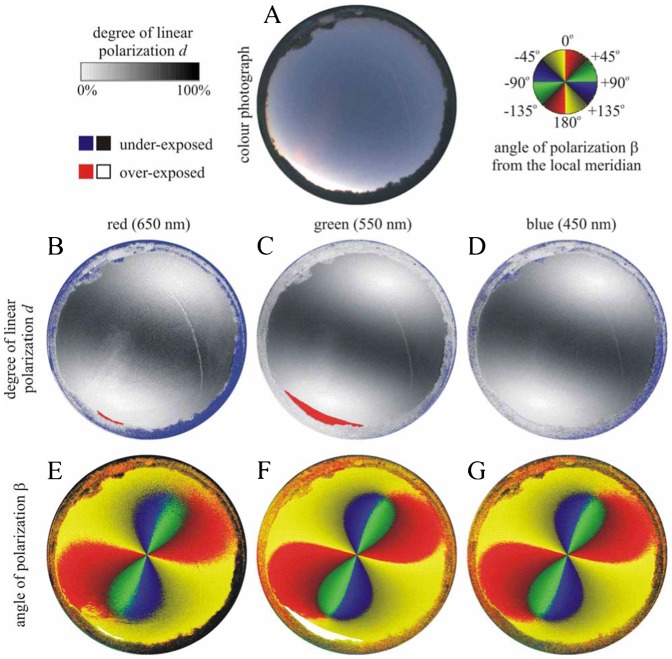
As Fig. 4 for the nearly clear sky no. 618